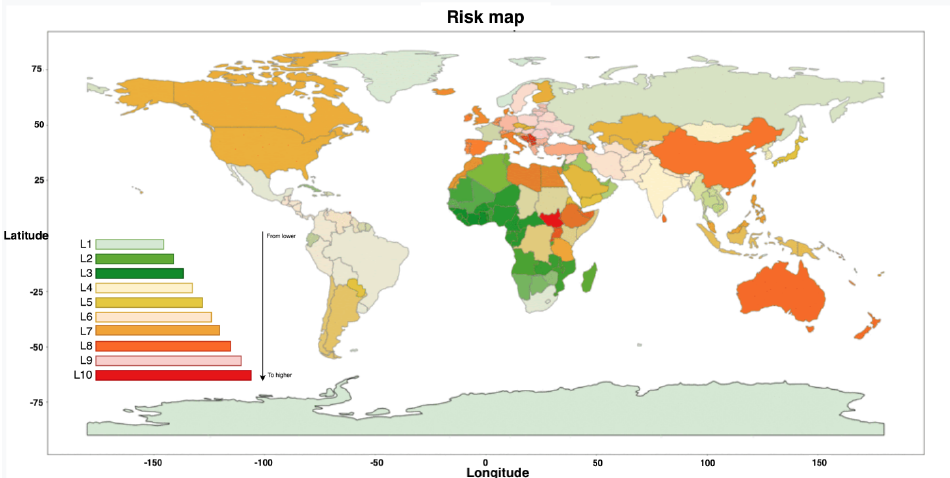
Figure 4. Example of risk map at low spatial